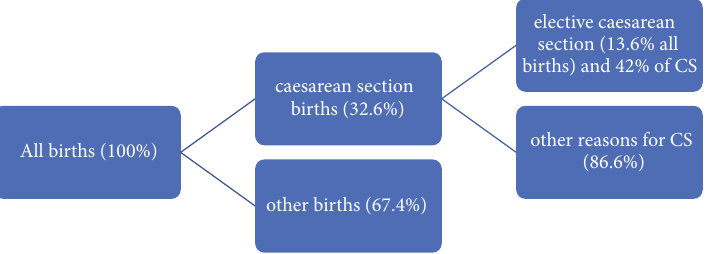
Figure 1: Flow chart showing deliveries and CS for the year 2017 at Duayaw Nkwanta